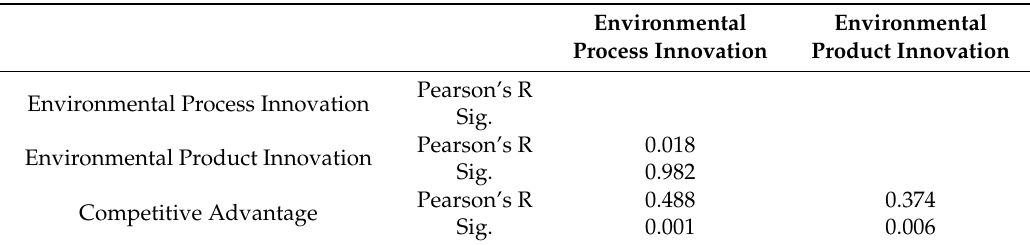
Table 8. Environmental innovation constructs’ and competitive advantage